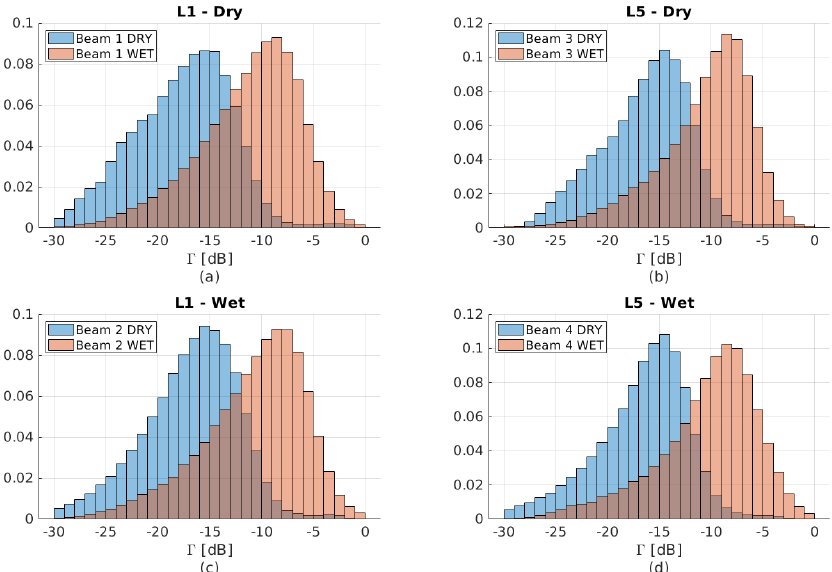
Figure 7. MIR reflectivity Probability Density Function (PDF) for both ( a , b ) Dry and ( c , d ) Wet flights. The Y-axis is the normalized counts values of the PDF, and the average reflectivity for the four beams at the Dry flight are: − 17.6 dB, − 16.8 dB, − 16.3 dB, and − 16.7 dB, with a standard deviation of ∼ 4.7 dB; and for the Wet flight are: − 11.2 dB, − 10.8 dB, − 10.5 dB, and − 10.4 dB, with a standard deviation of ∼ 4.8 dB. Note that, the tracking algorithm selects those satellites whose reflection has a very small incidence, and the average incidence angle for the four beams is below ∼ 30 ◦